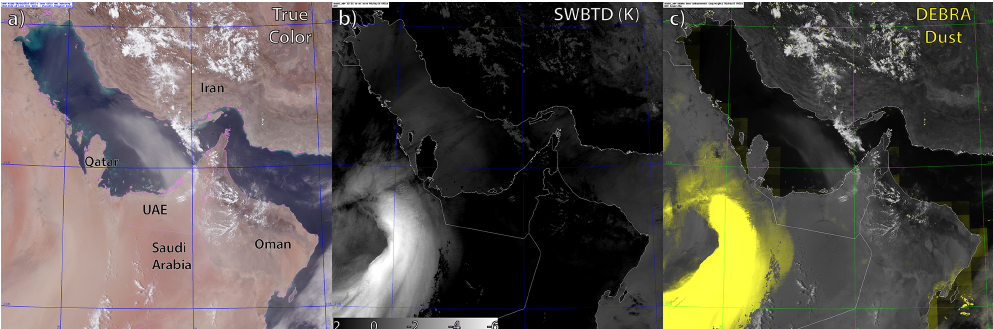
Figure 4. Suomi NPP VIIRS imagery showing (a) true color, (b) the SWBTD (scaled here from 2 to − 6K), and (c) DEBRA-dust (enhanced dust in yellow) imagery composite from 4 August 2016, 09:21UTC. Whereas DEBRA identifies the western dust plume prominently, it fails to identify the eastern “missing” plume over the eastern UAE and extending offshore. The tan coloration of this missing plume, indicative of mineral composition, is revealed via true color imagery in contrast to nearby meteorological clouds that appear